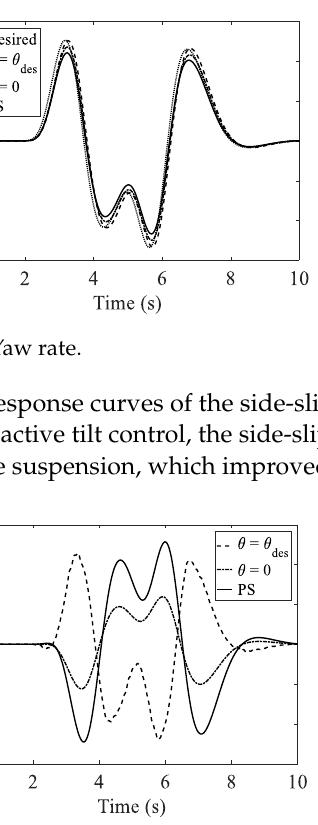
Figure 19. Side-slip angle of the vehicle center of gravity.